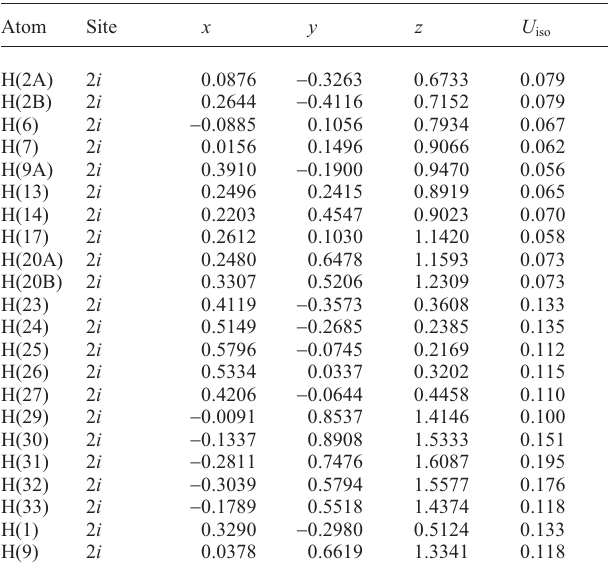
Table 2. Atomic coordinates and displacement parameters (in Å 2 )